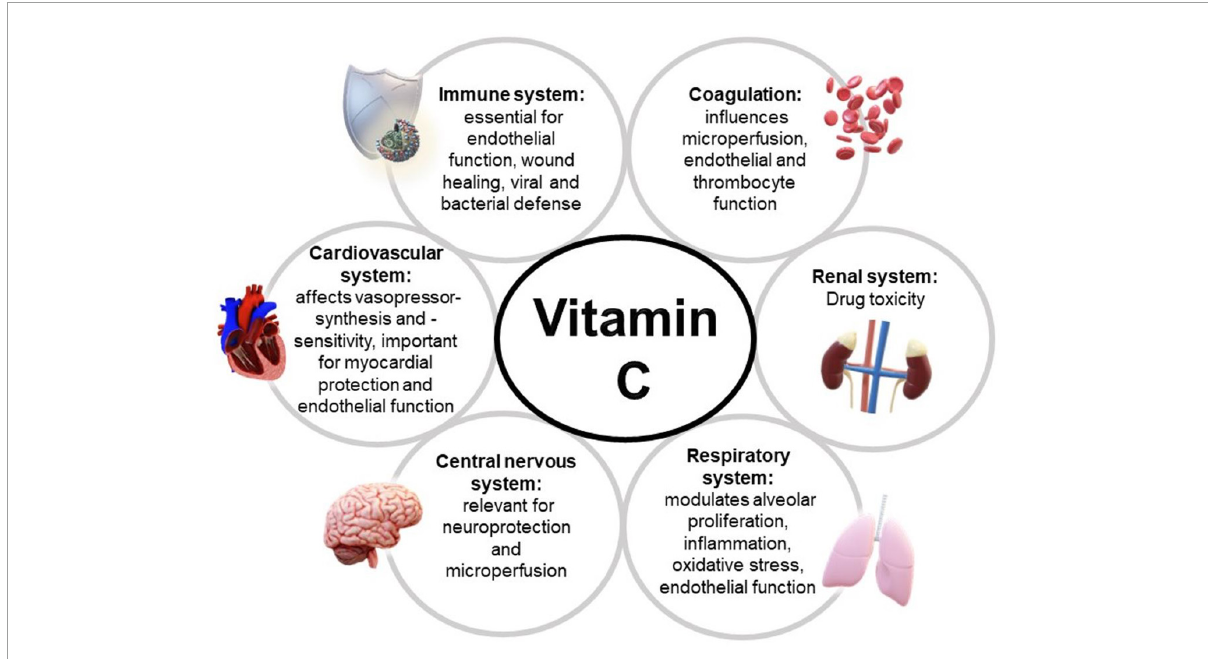
FIGURE2 Vitamin C’s influence of different organ